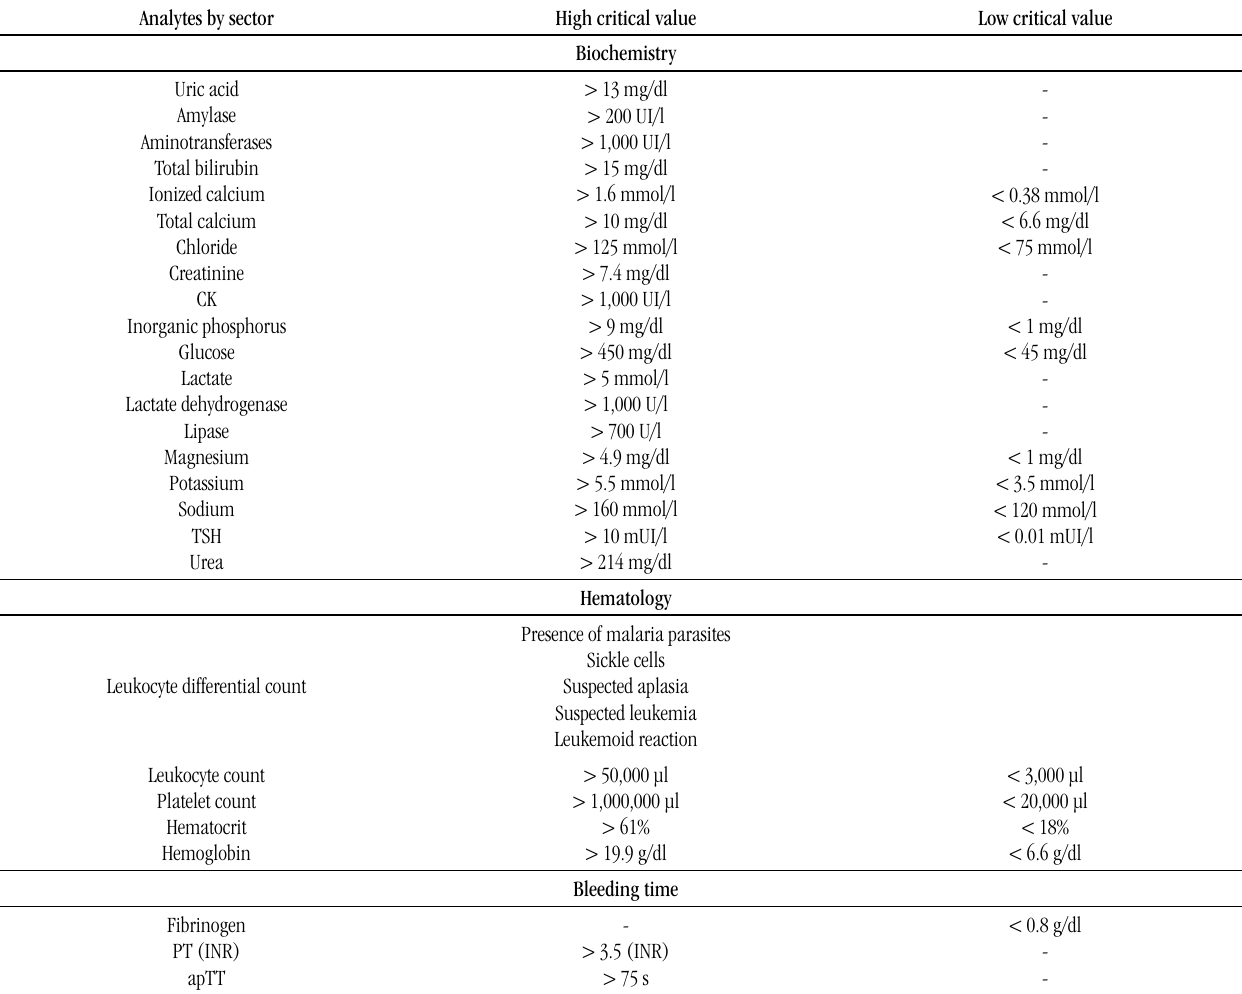
tABLE 2 – List of critical values, for adult and pediatric patients, of PROCAPE